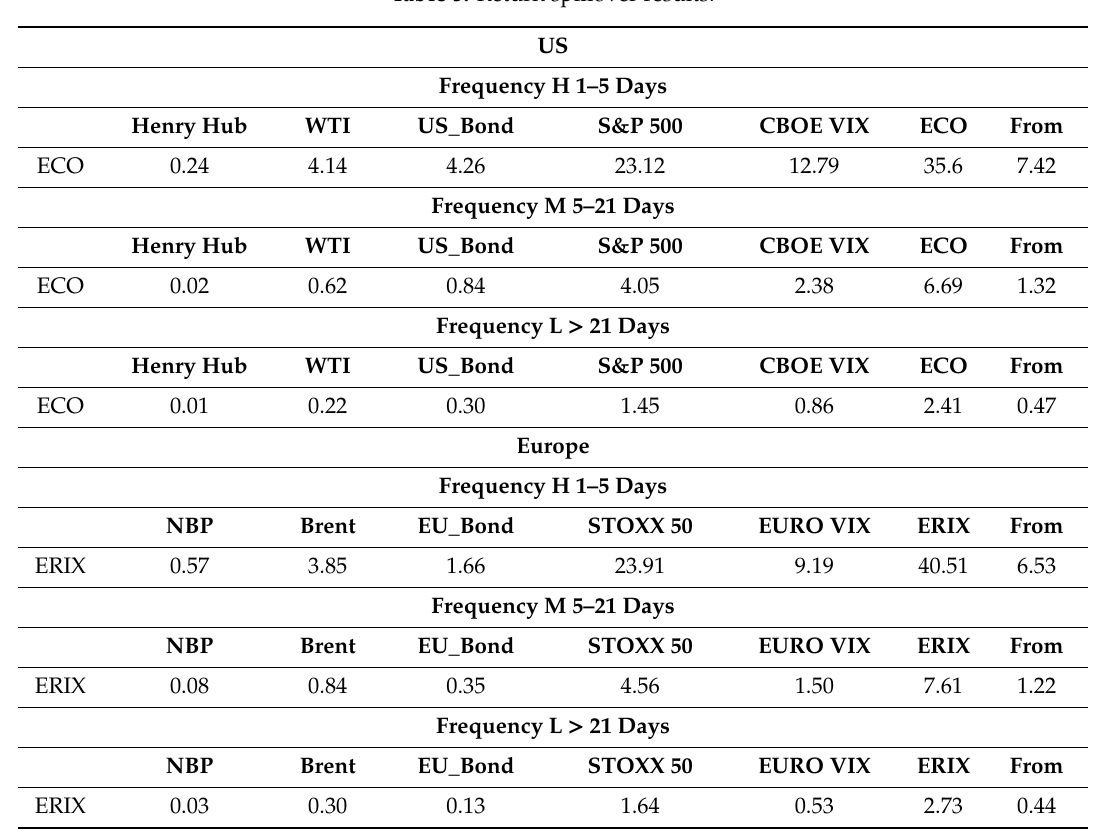
Table 5. Return spillover